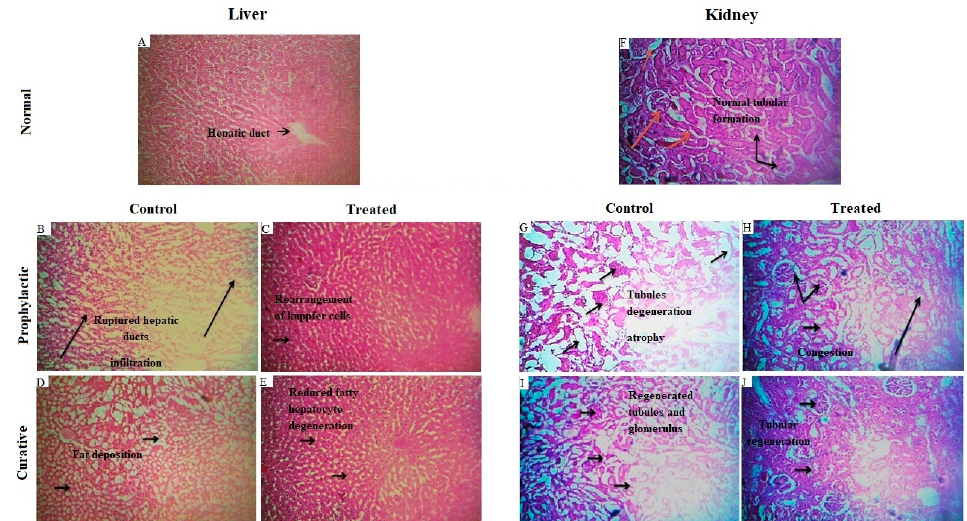
Figure 4. Histopathology of rat liver sections: ( A ) Normal control group: no significant deviation from the normal histological architecture of hepatocytes was observed. The arrowhead represents the position of the central vein. ( B ) Prophylactic control group: cisplatin-induced toxicity resulted in significant devastation of hepatocytes with the disarray of the architecture as compared to the normal control group. ( C ) Prophylactic group: initiation of significant regenerative changes and more regular alignment of hepatocytes as compared to the prophylactic control group. ( D ) Curative control group: revealed significant fatty changes and degenerative changes in the architecture of damaged hepatocytes as compared to the control group. ( E ) Curative group: exhibited regenerative changes in the hepatocyte architecture as compared to the curative control group. Histopathology of rat kidney sections: ( F ) Normal control: no significant deviation from the normal architecture of glomerulus and tubules. The portions marked by the arrowhead indicate glomerulus and tubular portions of nephrons. ( G ) Prophylactic control group: the normal architecture was significantly a ff ected by the toxicity of cisplatin representing marked Glomeruli congestion, atrophy, and tubular damage. ( H ) Prophylactic group: revealed initiation of marked regenerative changes in the architecture through glomerular and tubular regeneration as compared to the prophylactic control group. ( I ) Curative control group: significant congestion and degeneration of glomeruli and marked destruction of tubules were observed as compared to the normal control group. ( J ) Curative group: initiation of regenerative changes in the architecture (glomerular and tubular regeneration) was observed as compared to the curative control